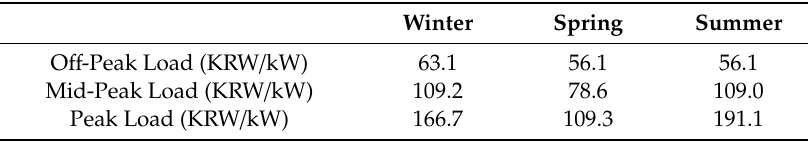
Table 2. Electric rates of TOU tari ff for industrial